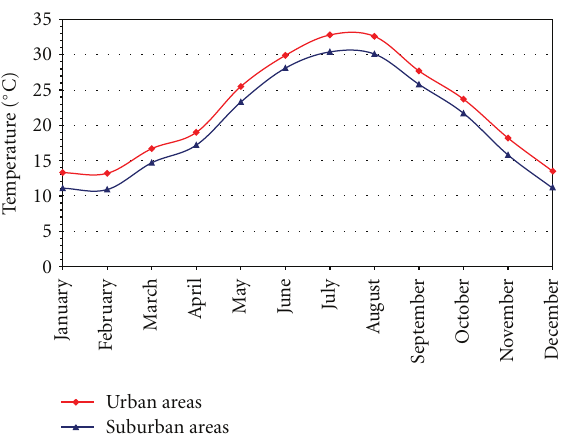
Figure 3: Annual variation of mean monthly wind speed for the urban and suburban areas within the GAA. Period